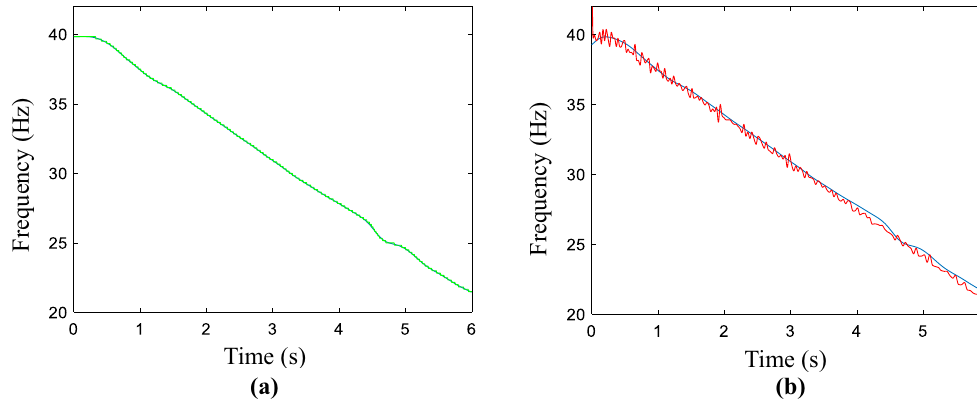
Figure 5. Results of the refined IF. ( a ) The estimated and refined result, ( b ) the real and refined result.